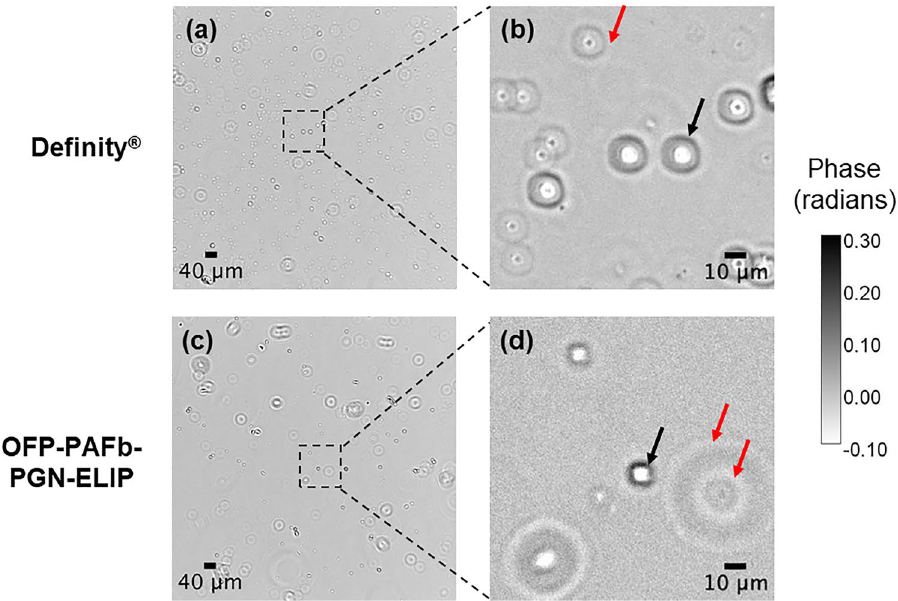
Figure 4. Spatial light interference microscopy (SLIM) images of (a, b) Definity and (c, d) OFP-PAFb-PGN- ELIP using a 10 × objective. Images were taken of microbubbles withdrawn directly from vials (no infusion). The black arrows indicate lipid shells, and the red arrows indicate diffraction artifacts which appear as white rings.